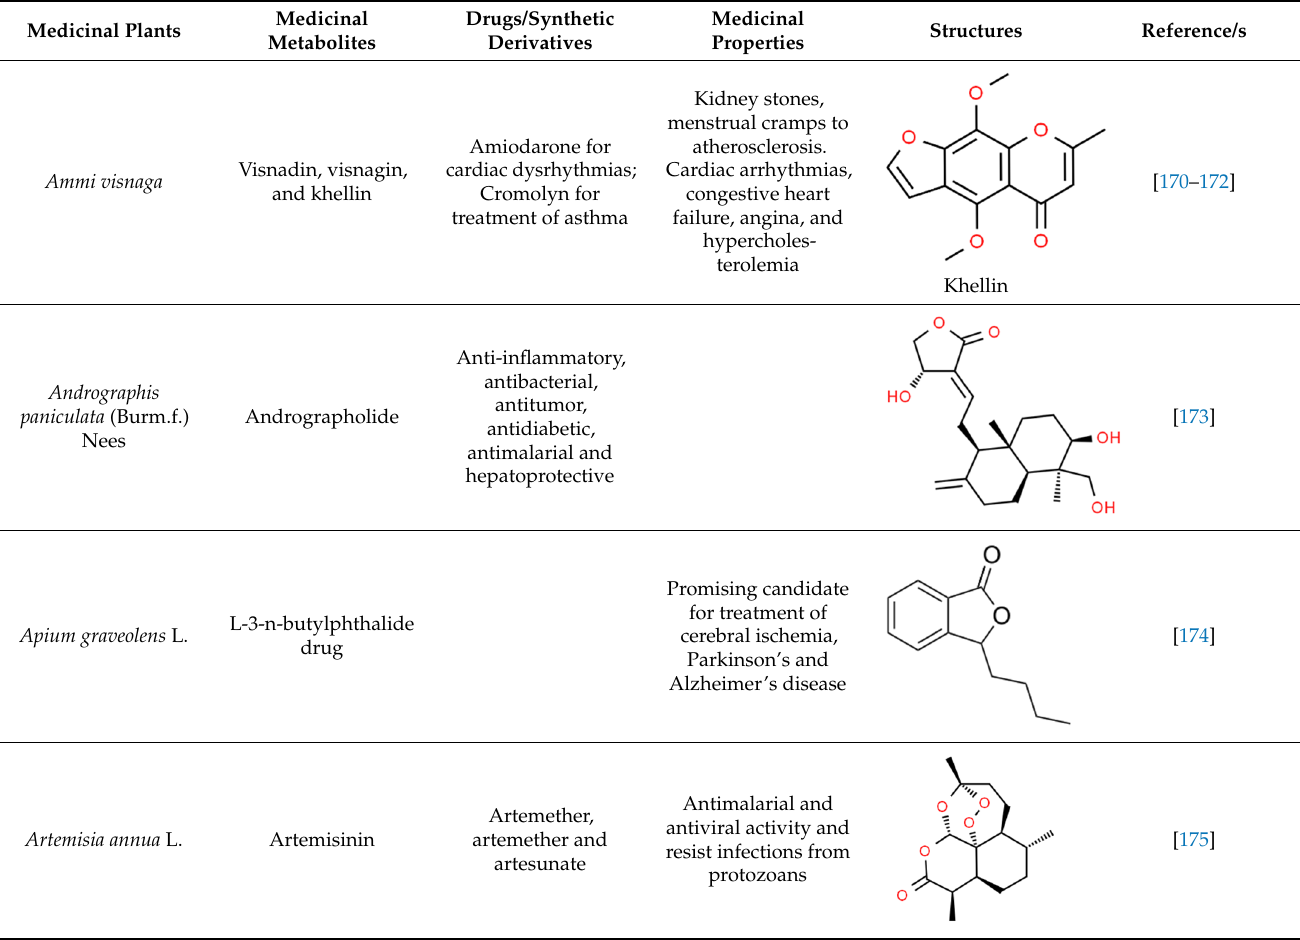
Table 2. Medicinal Properties and Chemical Structures of Some Metabolically Bioactive Compounds from Medicinal Plant Species. (Chemical Structures were Drawn with ChemSpider Software).